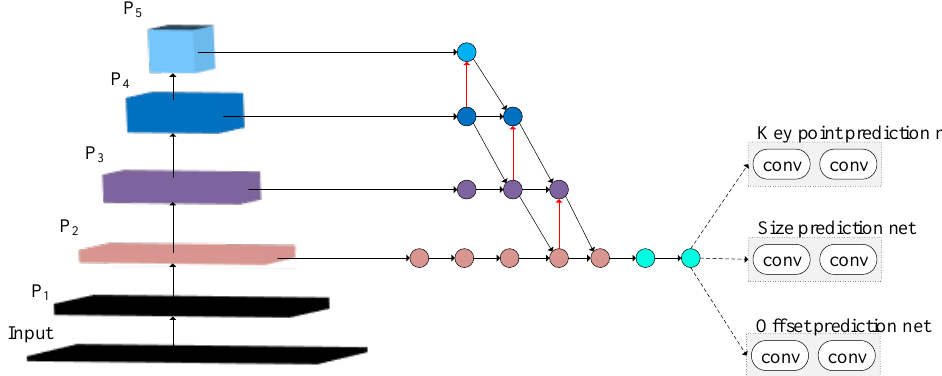
Figure 6. The CFACN and ROI-CFACN overall